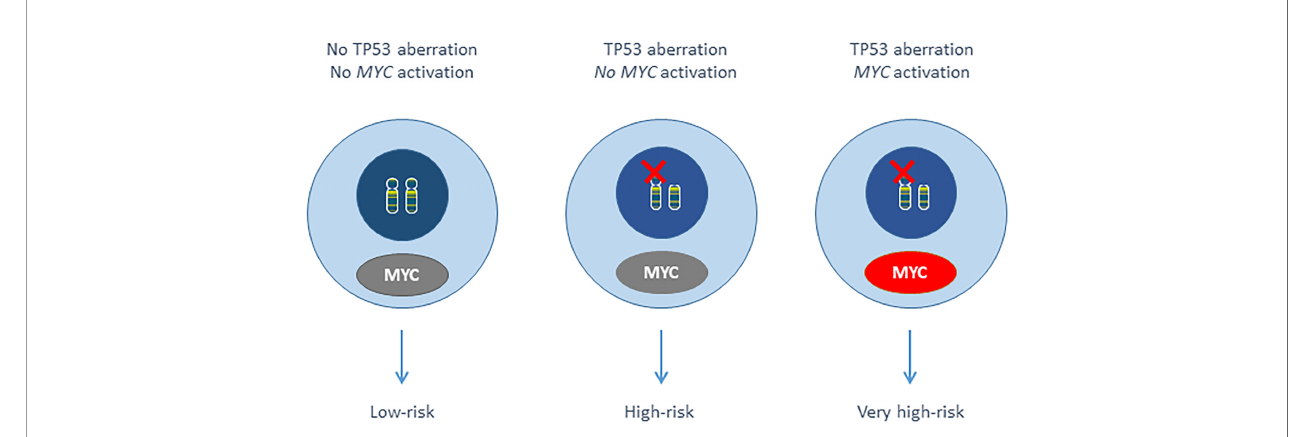
FIGURE 1 | Putative scheme of double-hit